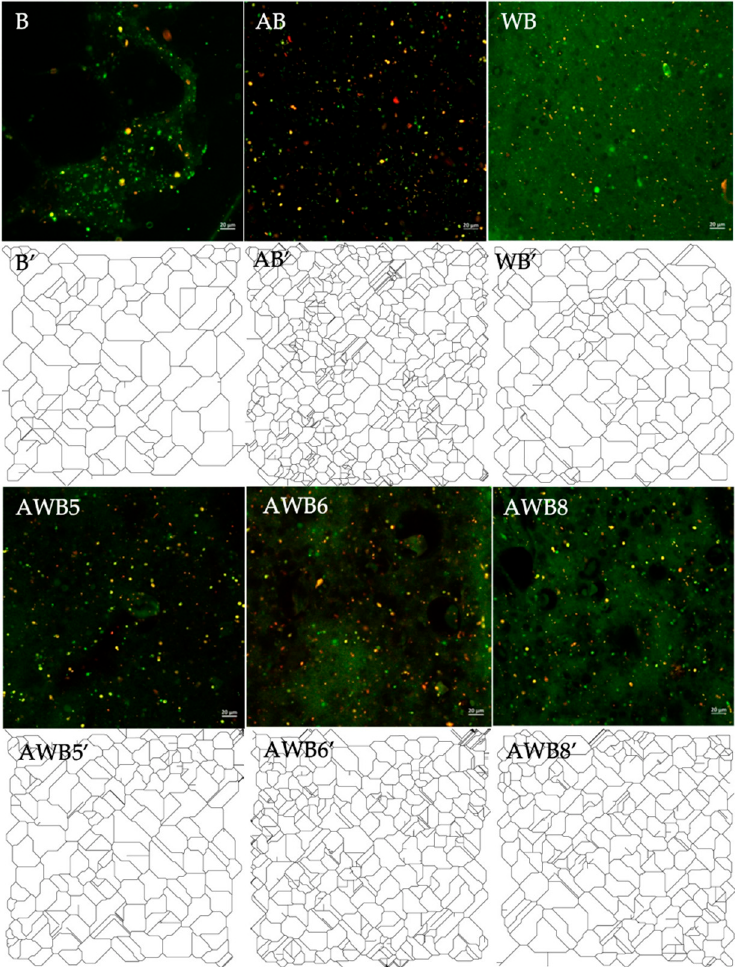
Figure 2. Micrographs obtained by laser scanning confocal microscopy (scale: 200 microns, zoom central part of the beads) of beads with S. boulardii . Skeletonization of micrographs obtained through Image J software (nomenclature with apostrophe).